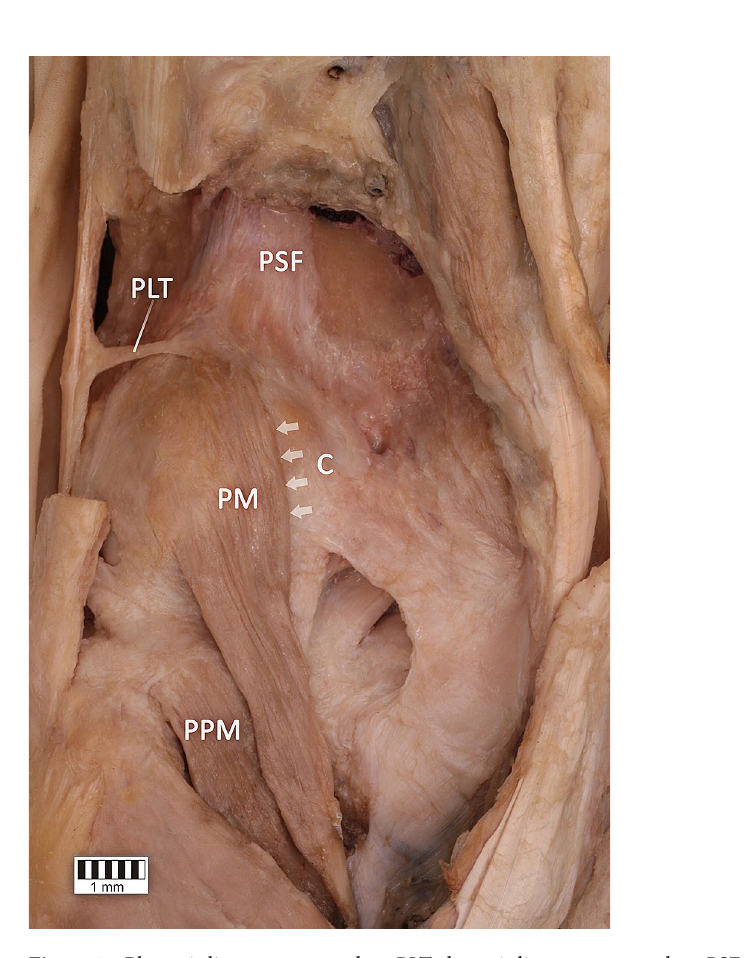
Figure 1. Plantaris ligamentous tendon. PLT plantaris ligamentous tendon; PSF posterior surface of the femur; C capsule of the knee joint; PM plantaris muscle; PPM popliteus muscle . White arrowheads show the attachment of the plantaris muscle to the capsule of the knee